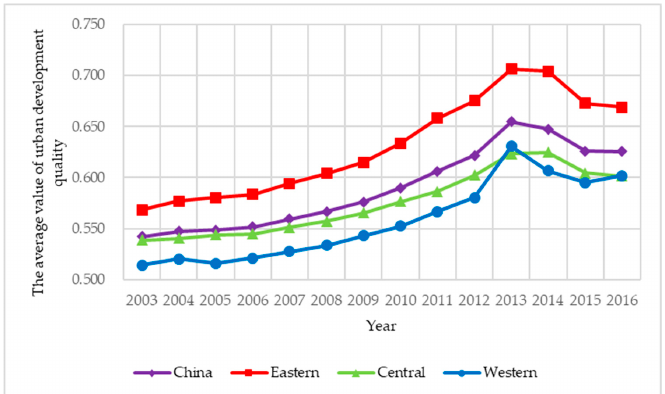
Figure 2. The average value of urban development quality in China during 2003–2016.